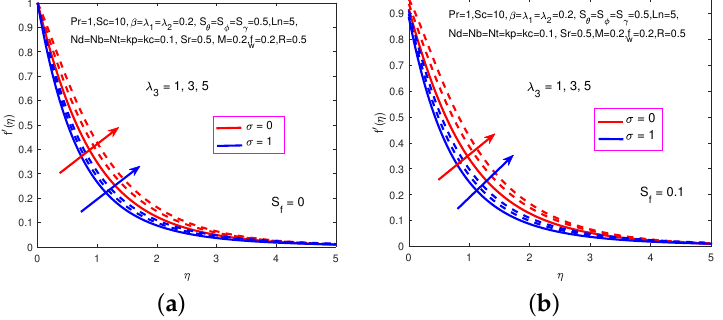
Figure 5. Influence of λ 3 and σ on f (cid:48) . ( a ) No hydrodynamic slip. ( b ) With hydrodynamic slip.